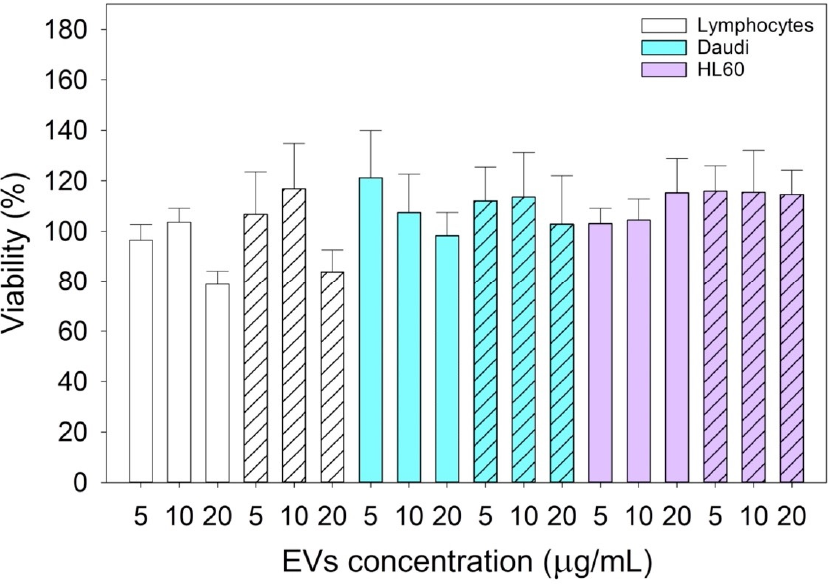
Figure 4. Cytotoxicity assay results of lymphocytes, Daudi, and HL60 cell lines treated for 24 (solid color bars) and 48 (dashed bars) hours with 5, 10, and 20 µg/mL of concentrated nEV suspensions. Plotted data are the mean ± SE. The comparisons between cell lines, times, and types of treatments were performed using the three-way ANOVA test, and no statistically significant differences resulted. Independent experiments were carried out three times.